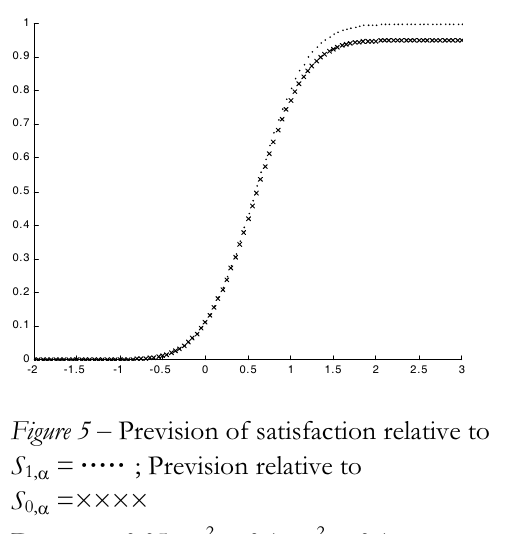
Figure 5 – Prevision of satisfaction relative to